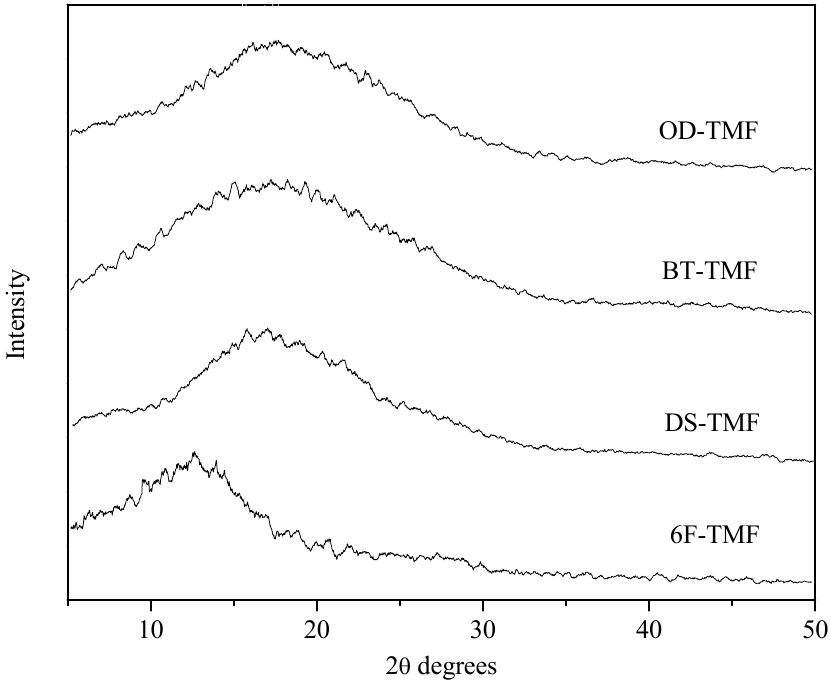
Figure 4. WAXD patterns determined for TMF-based polyimide